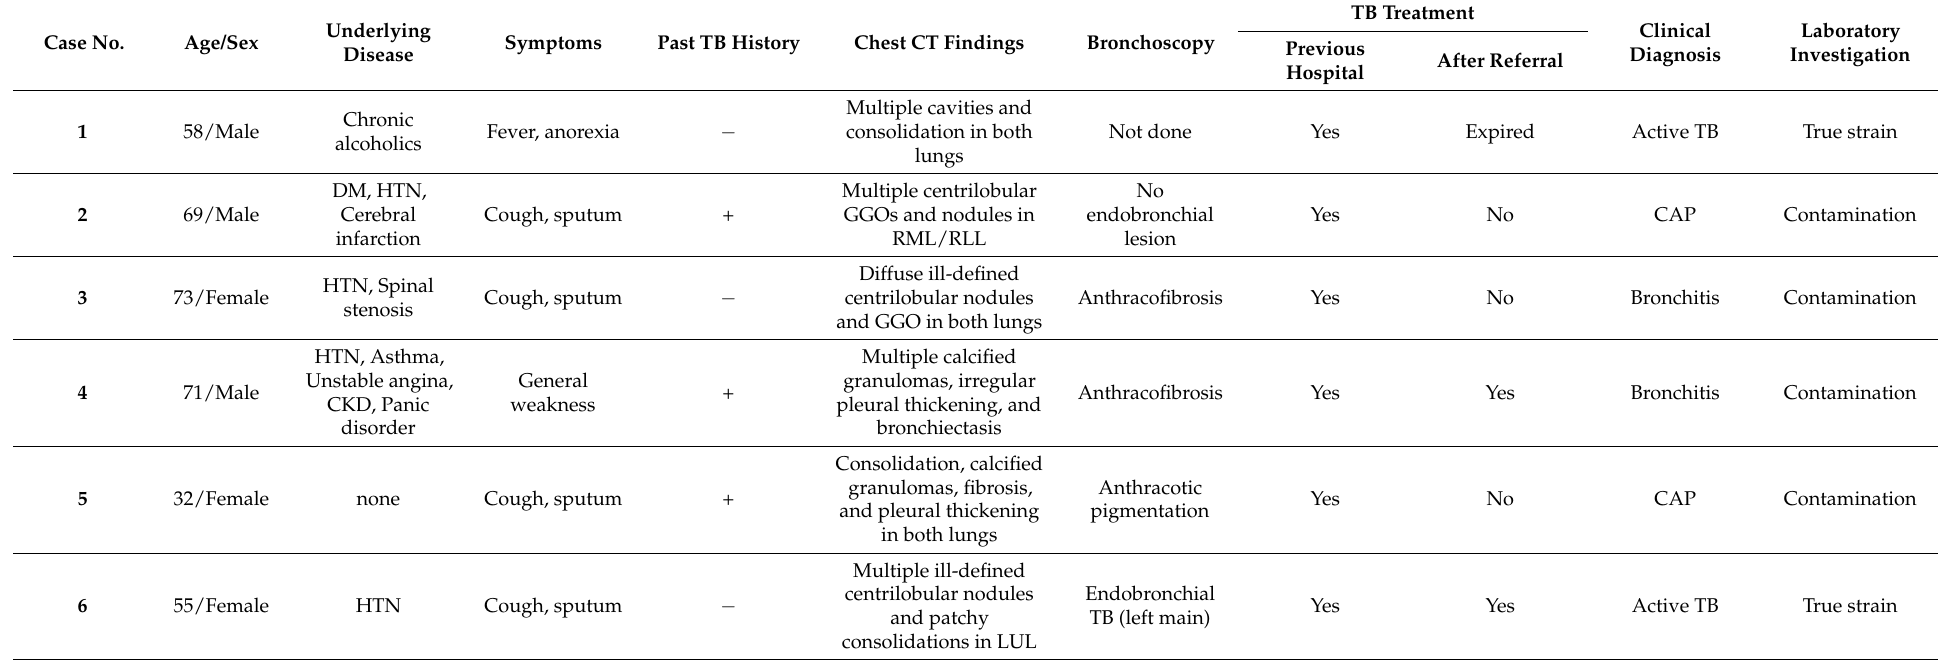
Table 2. Clinical information of six patients with positive Mycobacterium tuberculosis culture as analyzed at a private laboratory company.